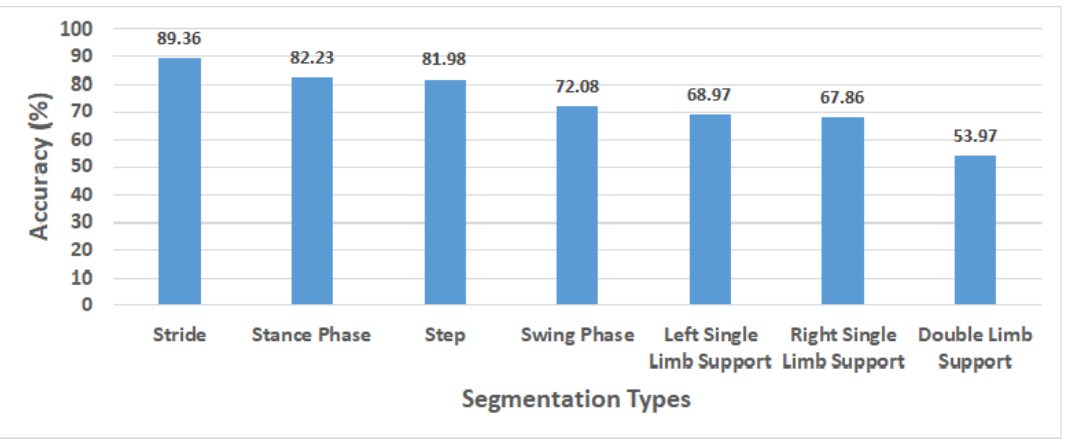
Figure 6. The comparison of average accuracy on Acc+Gyro sensor combination using seven different segmentation types across 18 participants. The average accuracy was measured using SVM at optimal PCs number (68) on